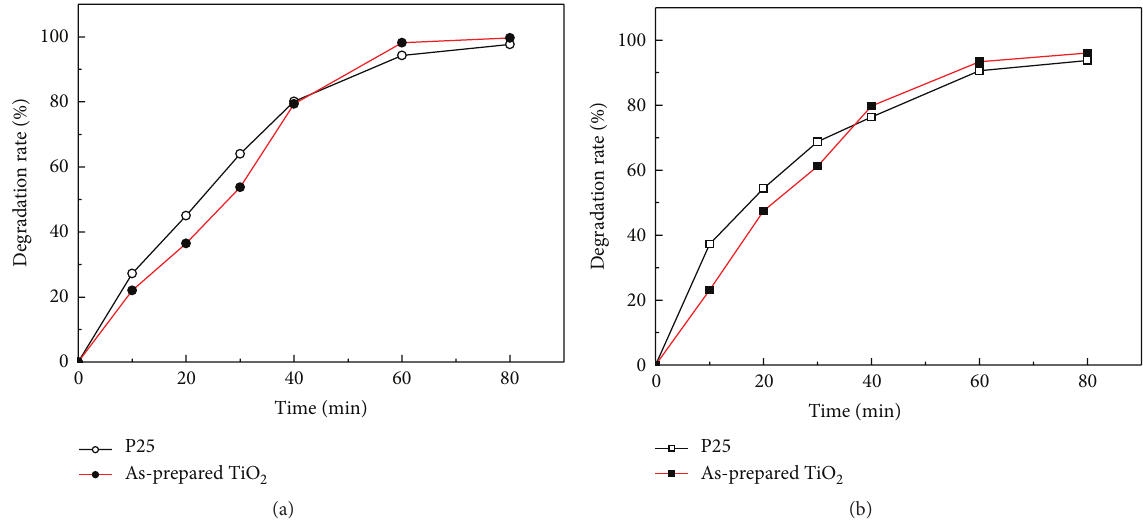
Figure 5: Photocatalytic degradation rate curves of different dye molecules as a function of irradiation time under UV light: (a) X-3B, (b)